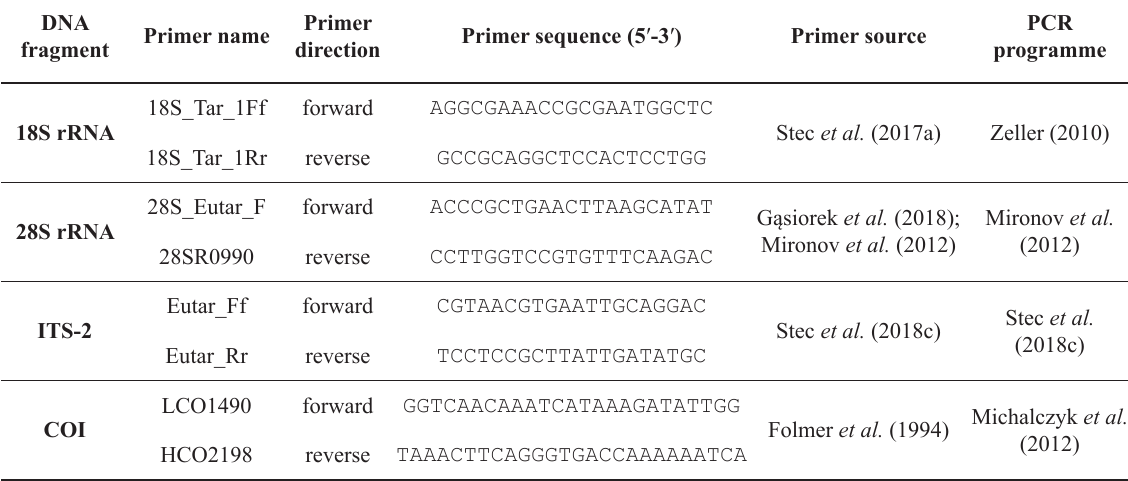
Table 1. Primers and references for PCR protocols for amplification of the four DNA fragments sequenced in